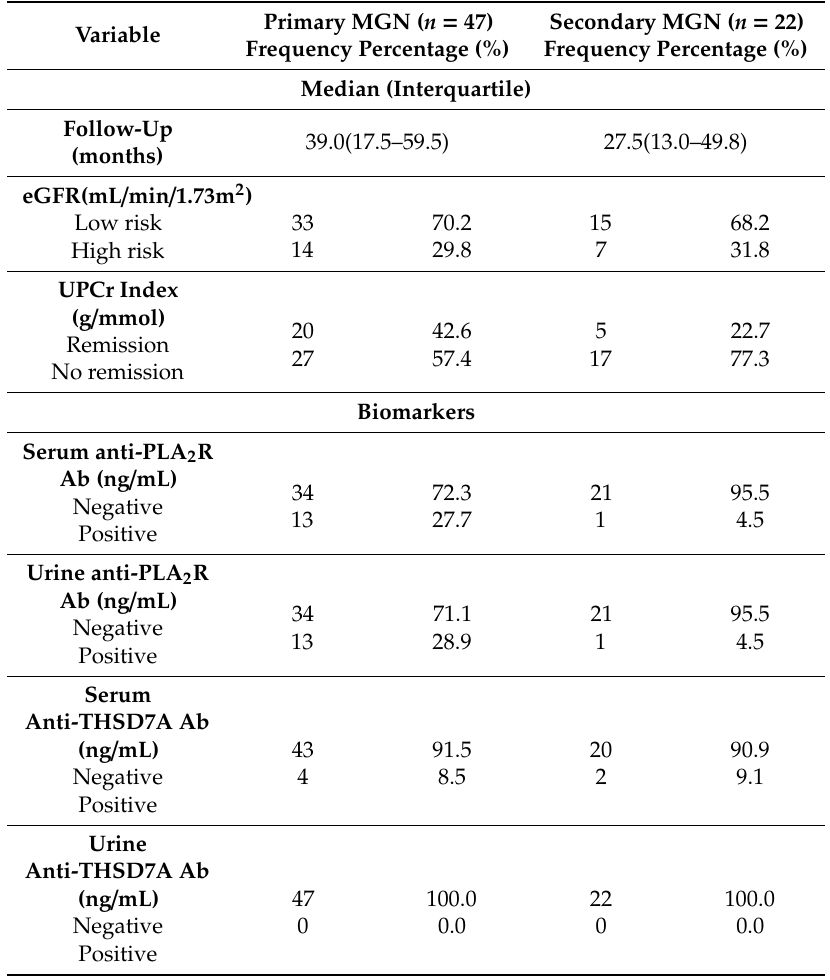
Table 2. General characteristics of subjects at the end of the follow-up